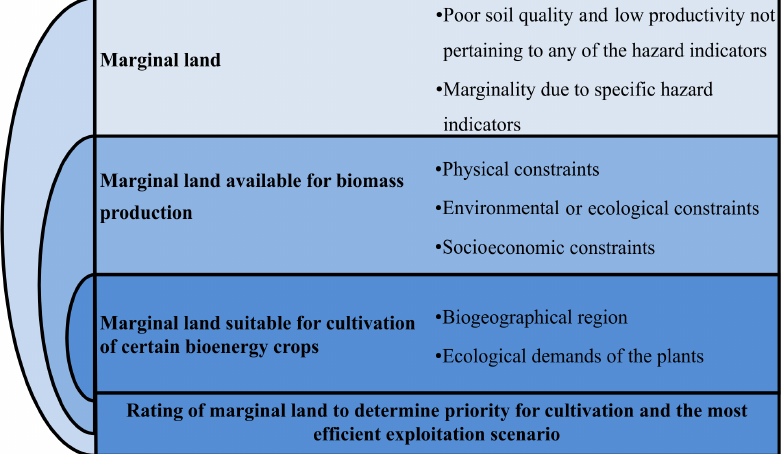
Figure 2. SEEMLA